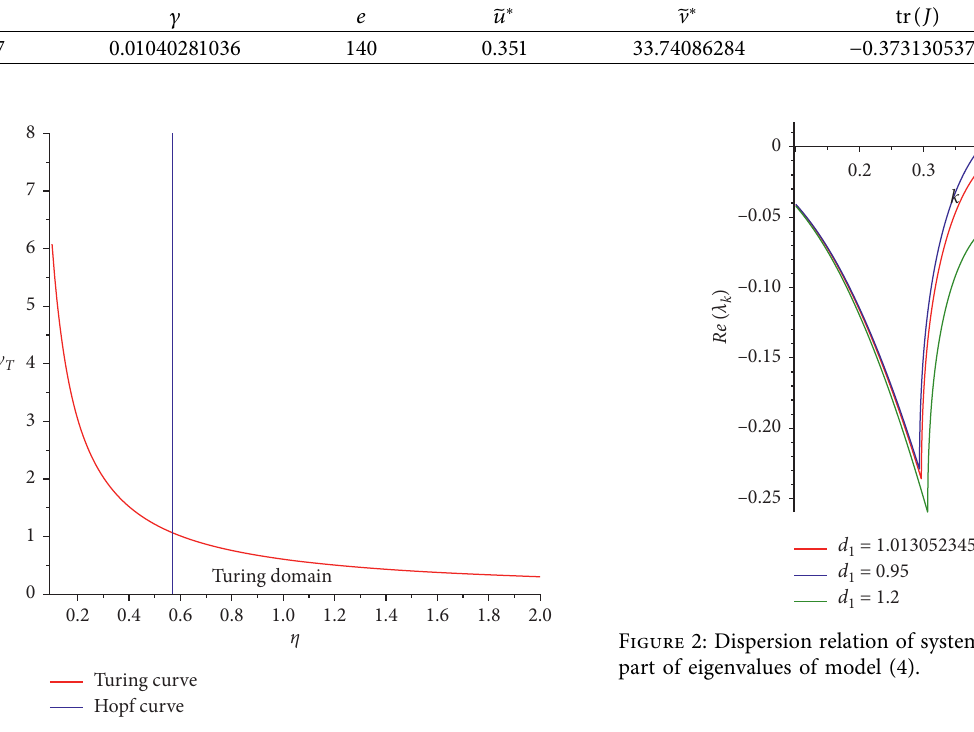
Figure 1: Turing domain of model (4).